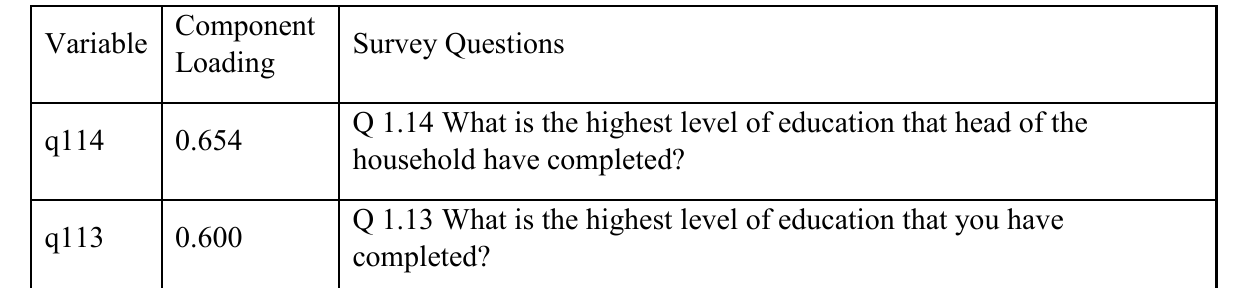
Table 1.32: Variables defining Adaptive Resilience